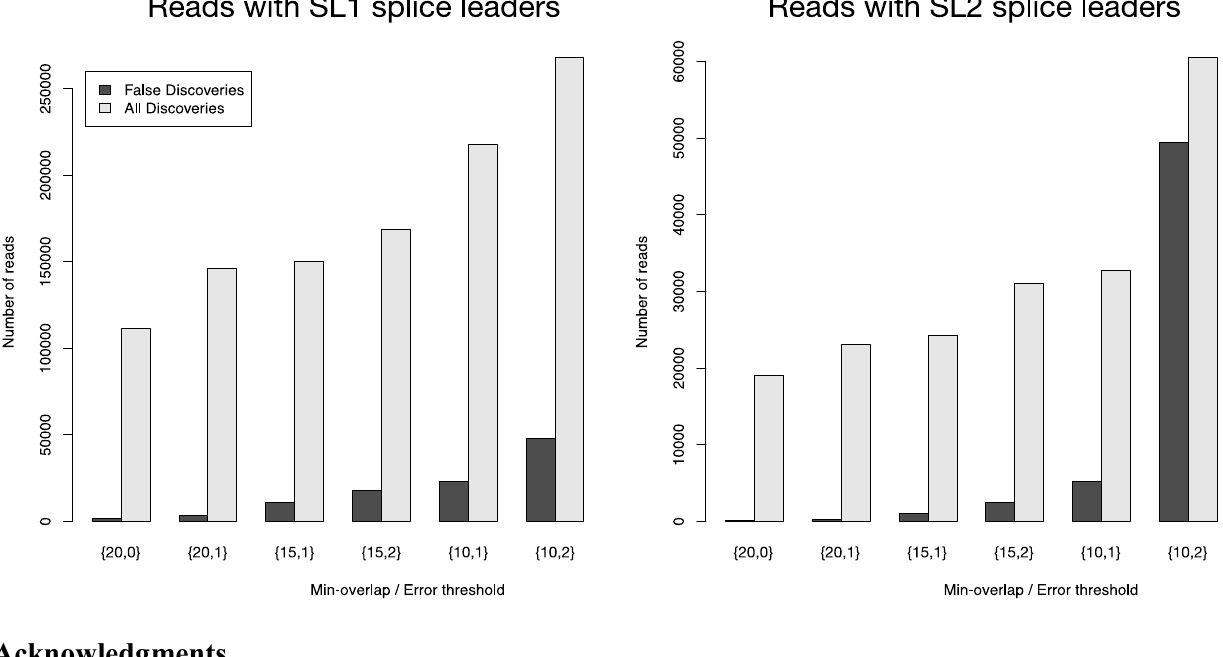
Figure 4. Total number of identified splice leader sequences (light gray bars) and number of estimated false discoveries (black bars) for SL1 and SL2 in data set SRR353594. The following parameters were varied: --barcode-min-overlap {10,15,20}, --barcode-threshold {0,1,2} and --barcode-gap-cost was set to -100. All reads were either assigned to SL1 or SL2 if they passed the alignment criteria (preference is given to SL1 in case of equally scoring alignments). The ratio of all discoveries versus false discoveries is highest for the {20,0} parameter